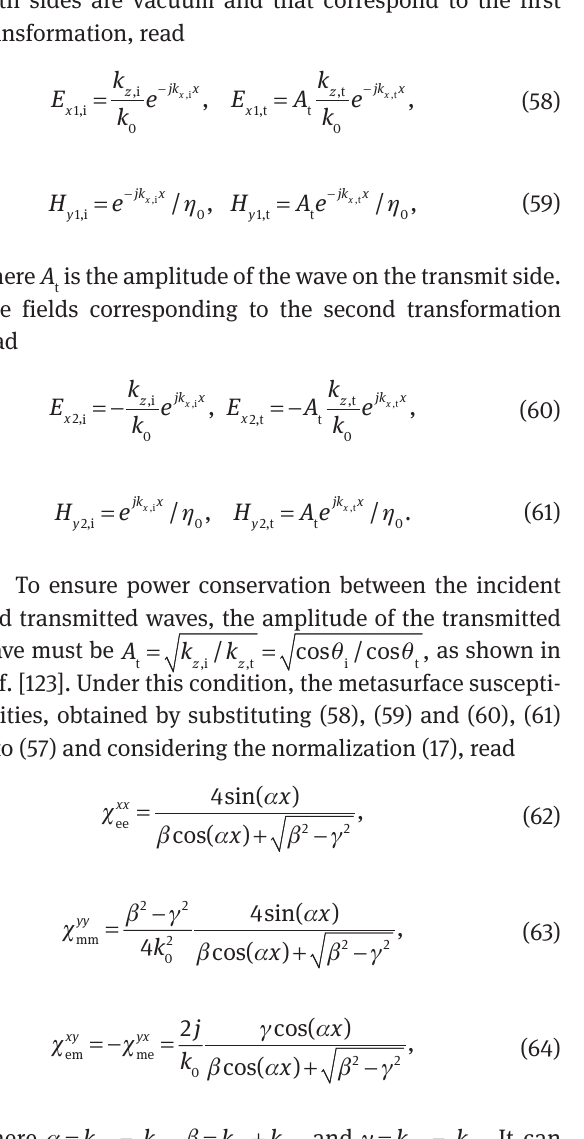
Figure 11: Full-wave simulations showing the performance of two refractive metasurfaces